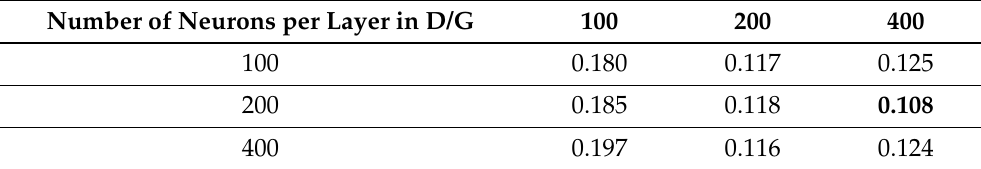
Table A4. tf n values for varying number of neurons per layer in both networks. Number of Neurons per Layer in